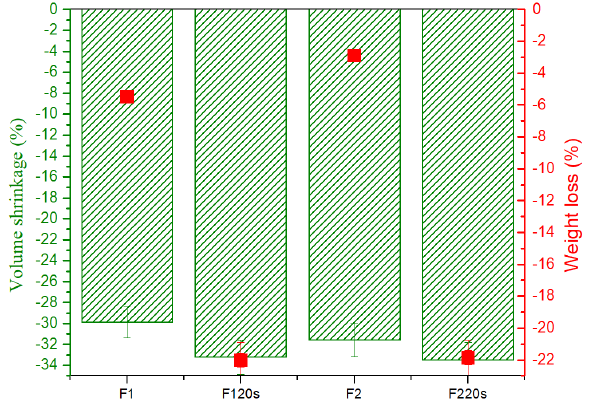
Figure 8. The effect of heat treatment on shrinkage and weight loss of all forsterite samples.